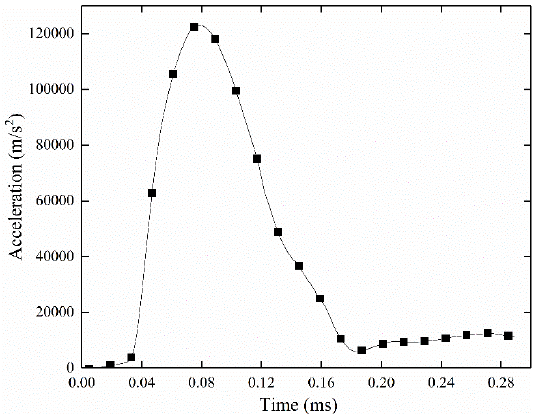
Figure 14. Valve spool acceleration during the opening process.